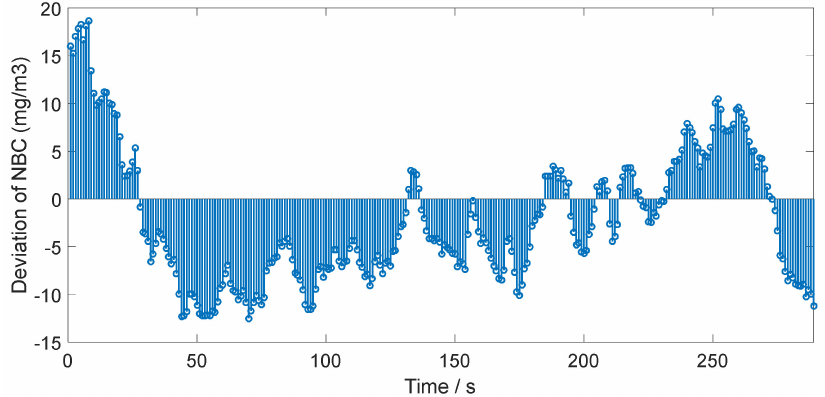
Figure 6. Deviation between predicted value and measured value of NO X of 12,000 t / d production